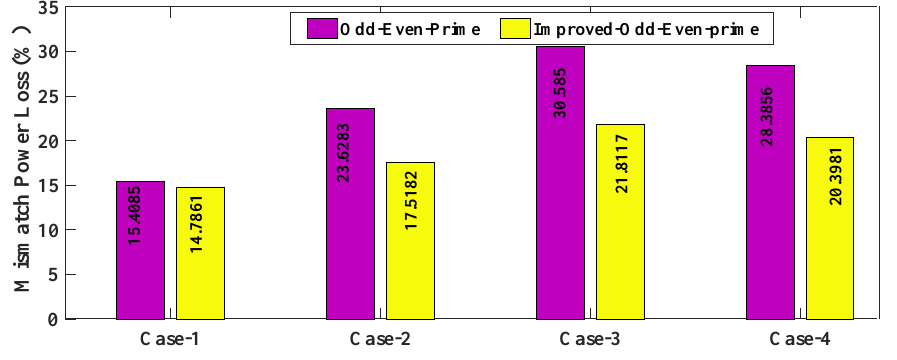
Figure 26. Mismatch power loss for 8 × 9 PV array.